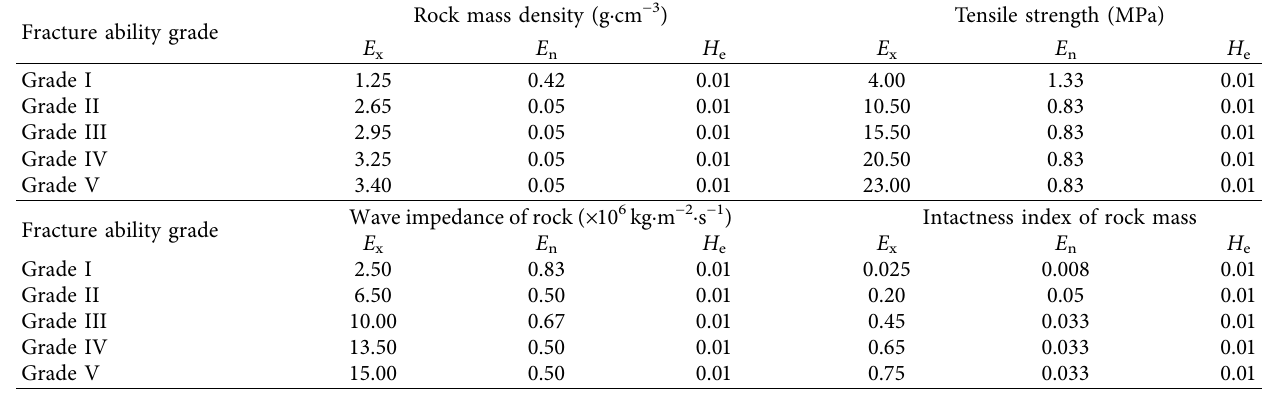
Table 9: Cloud digital characteristics of fracture ability evaluation